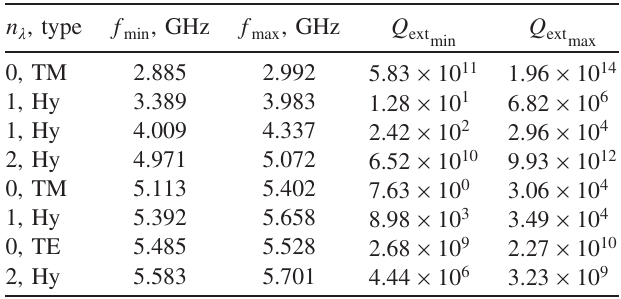
TABLE II. Lowest passbands of the S-DALINAC